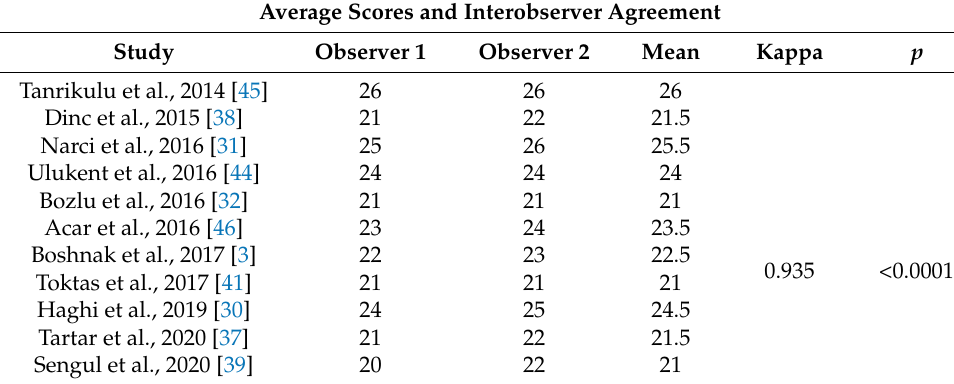
Table 3. The total scores and interobserver agreement (kappa